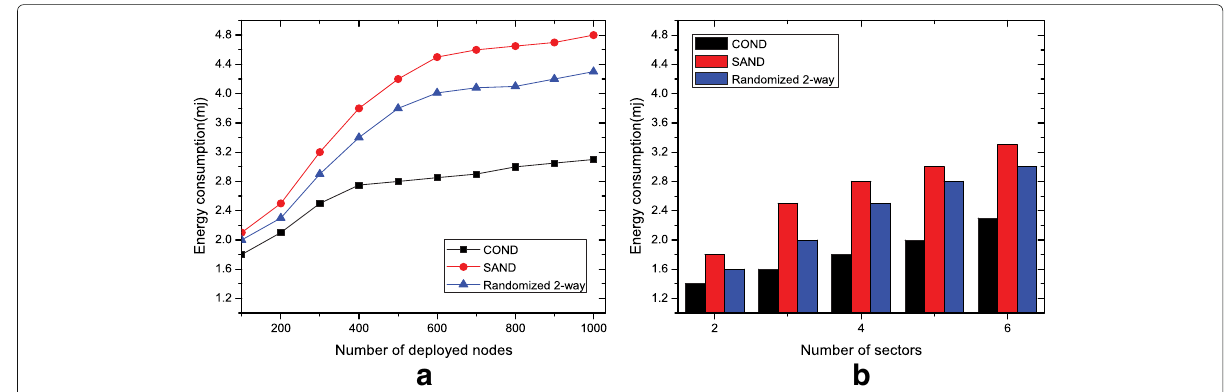
Fig. 9 Energy consumption performances of the studied algorithms. a Impact on varying number of sensors. b Impact on varying number of